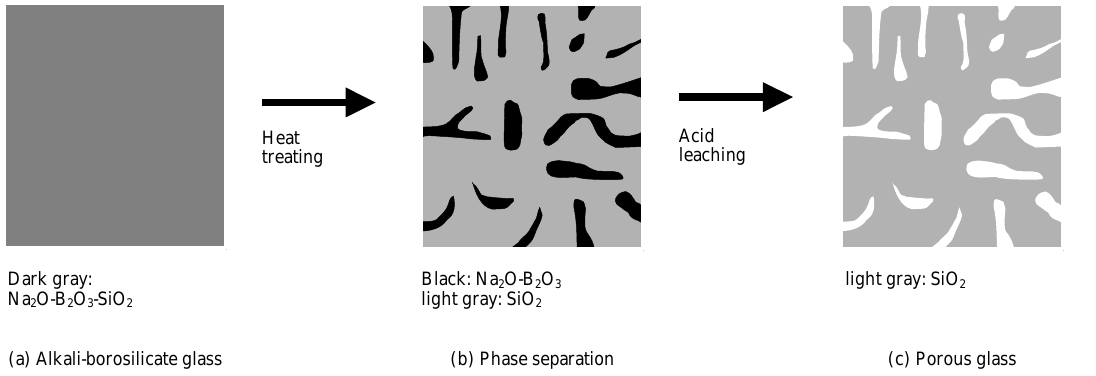
Fig. 9 Production process for porous glass (modified from Makishima